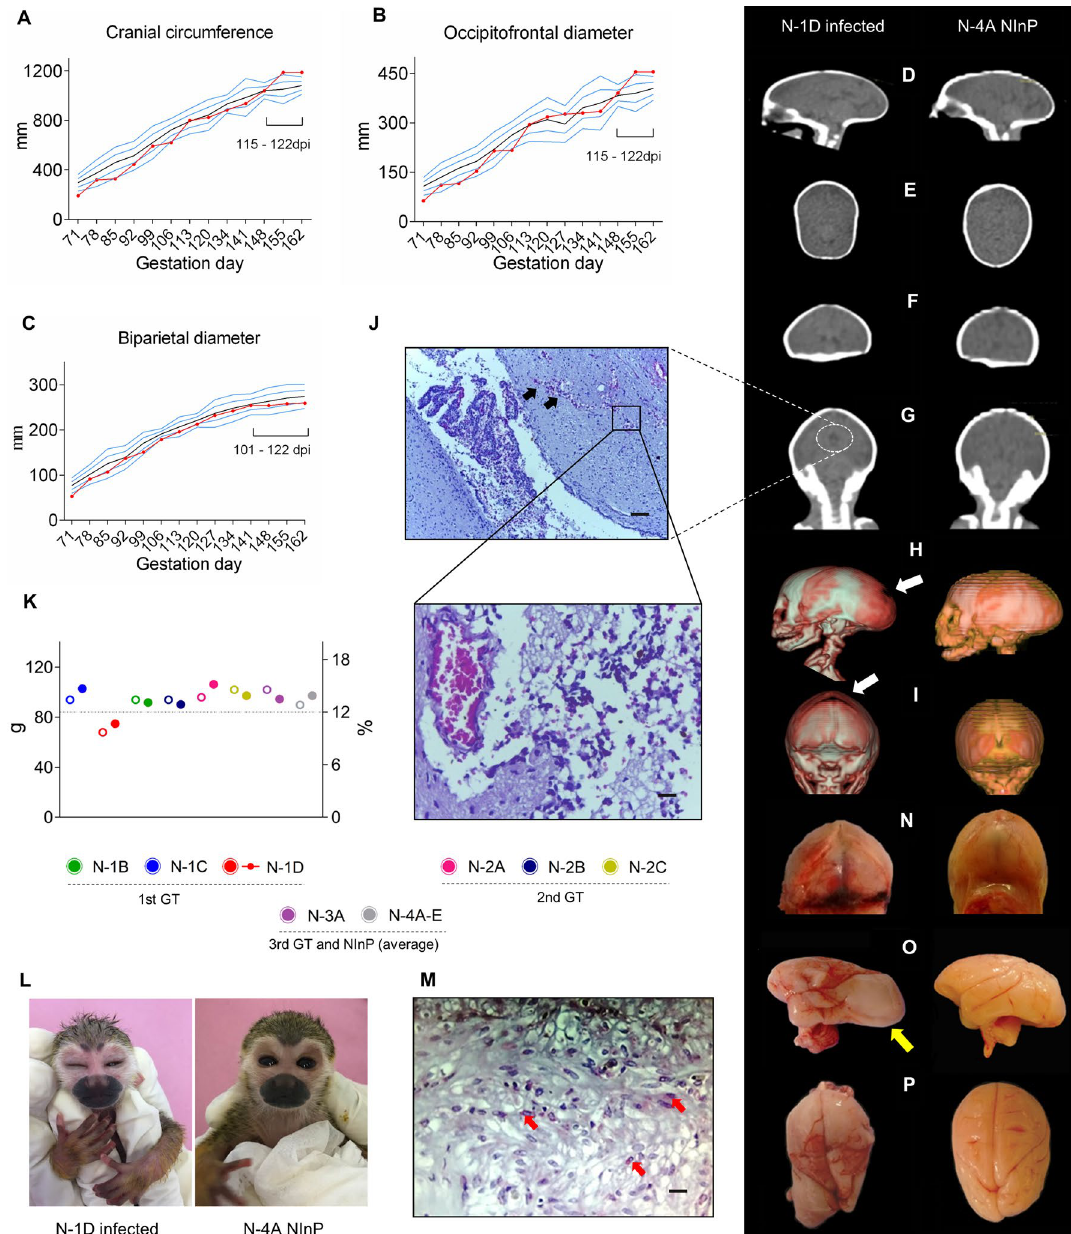
Figure 4. Experimental ZIKV infection in pregnant squirrel monkeys. Fetal growth and neuropathology following vertical ZIKV infection of newborn N-1D whose squirrel monkey mother (1D) was infected in the 1st GT (41 Gd) and comparison to a newborn (N-4A) in the NInP group. ( A , C ) Biometric measurements of fetuses at 162 Gd: cranial circumference ( A ), occipitofrontal diameter ( B ) and biparietal diameter ( C ). Average NInP (black line), 1, 2, -1 and -2 standard deviation—SD (blue line) and N-1D animal (red line). ( D ) CT of the skull in the sagittal section showing prominence of the occipital region. ( E , F ) Axial and coronal sections of the brain showing bone disproportion. ( G ) Coronal section showing mild right ventriculomegaly (incomplete circle). ( H , I ) 3D reconstruction of a brain CT showing posterior fontanelle closure (white arrows). ( J ) Mild ventriculomegaly on the right side, observed hemorrhage (black arrows) (100 × magnification scale bar, 25 µm) and perivascular edema and vasocongestion (box, magnification 400 × scale bar, 50 µm). ( K ) Low weight of N-1D on day 1 of life and proportion to mother’s weight. Weight (g) of newborns (open circle). Proportion (%) of newborn in relation to mother’s weight (closed circle). Minimum percentage of the newborn’s weight in relation to the mother’s size (black line) 45 . ( L ) Comparison of infected and uninfected newborns on the 1st day of life. ( M ) IHC markings of ZIKV-positive antigen/antibody reactions in the placenta (red arrows). 400 × magnification; scale bar, 50 µm. ( N ) Gross image of the skull cap with extensive subarachnoid hemorrhage in the posterior fontanelle region. ( O ) Gross brain image showing the incidence in the right occipital region (yellow arrow) and malformation of the right superior temporal sulcus. ( P ) Upper view of the brain showing asymmetry between the two cerebral hemispheres, with an enlargement of the right occipital hemisphere; lissencephaly in the right and left frontal, temporal, parietal and occipital lobes; and hemorrhage in the parietal